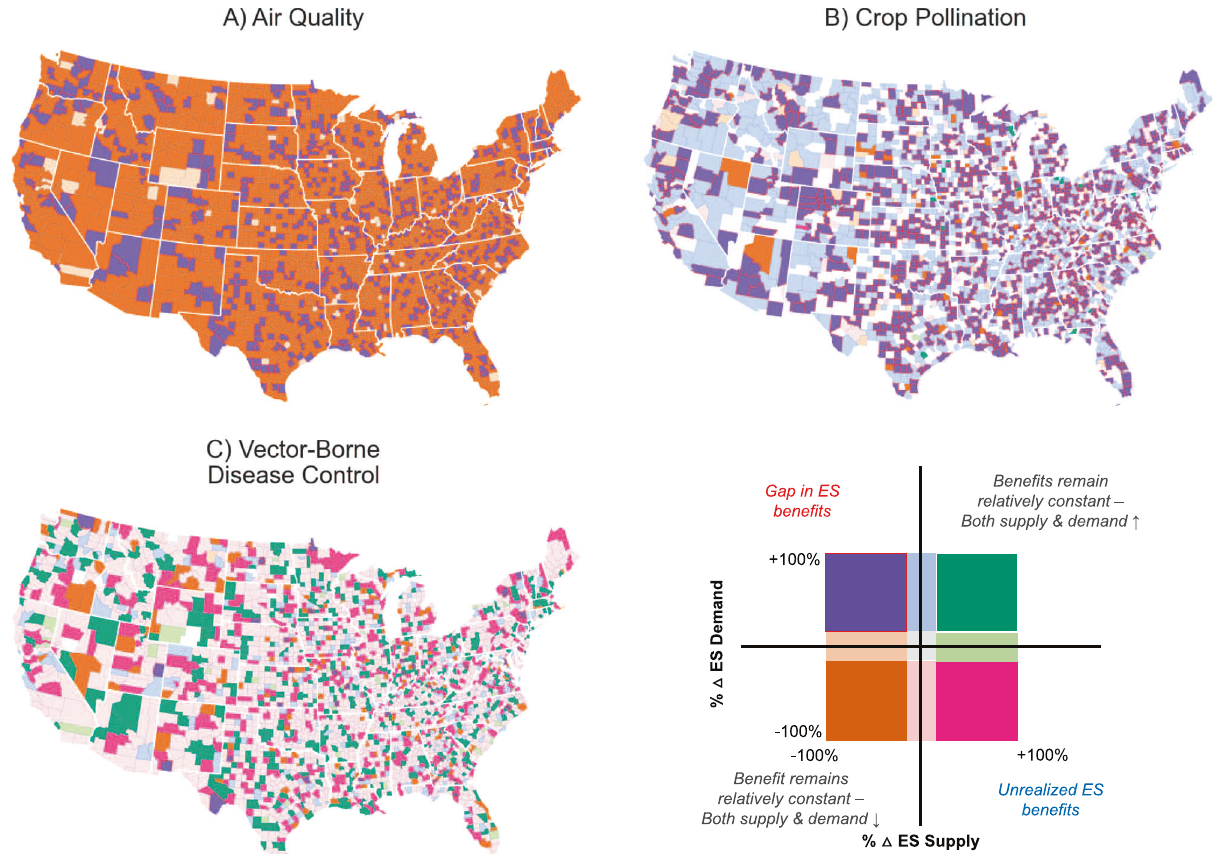
Fig. 3 Maps of changes in ES supply and demand between 2020 and 2100 at the county-level for scenario A2. Counties where supply or demand change between − 5 and 5% are plotted with lower hues. Purple areas outlined in red indicate counties where supply and demand mismatches are expected to occur. This color scheme does not distinguish the severity of projected mismatches between ES supply and demand. For instance, a 90% decrease in supply and a 90% increase in demand will result in a greater mismatch than a 10% decrease in supply and a 10% increase in